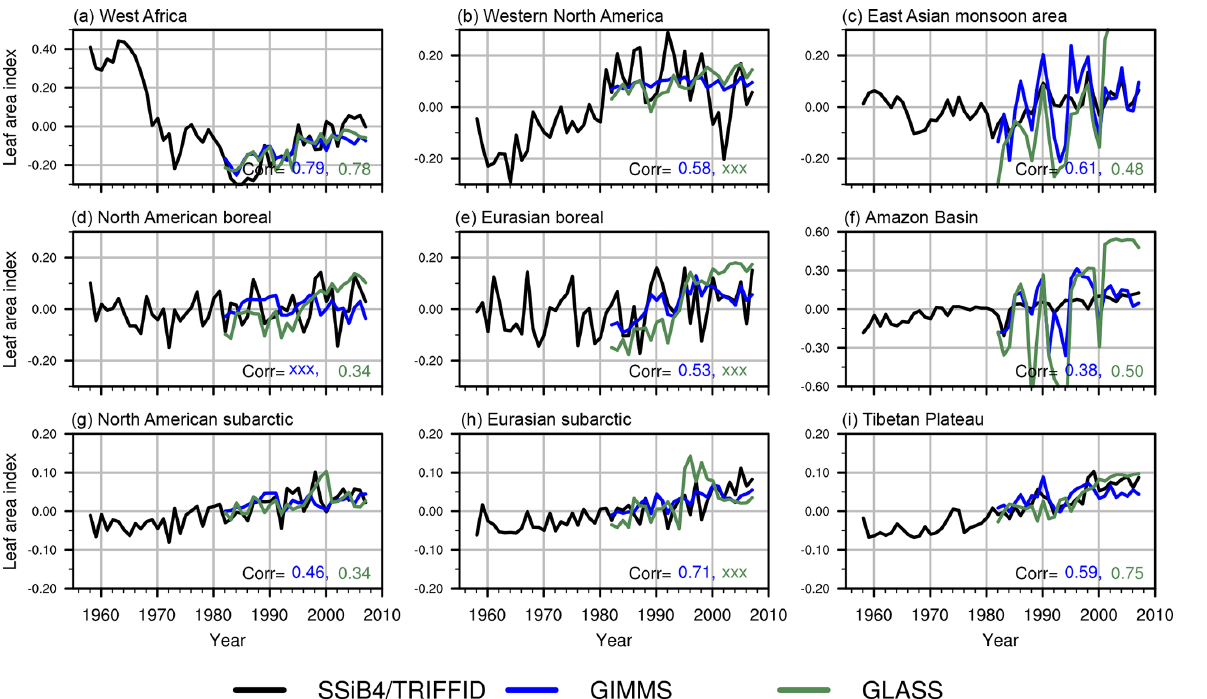
Figure 6. Comparison of standardized LAI anomalies between simulation and observations for nine subregions. Corr indicates the inter- annual correlation coefficient simulated (in black) LAI against the GIMMS (in blue) and the GLASS (in green). Only significant values ( P < 0 . 1) are shown, whereas non-significant values are masked by xxx.